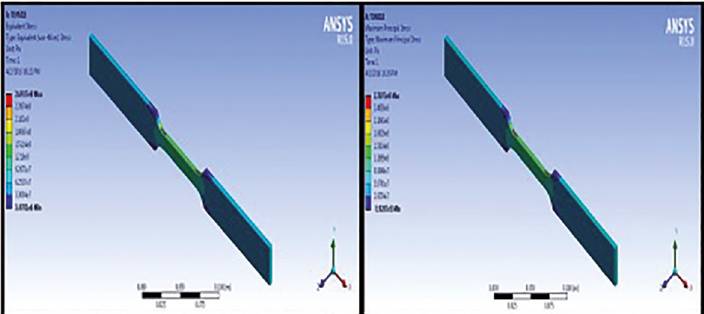
Figure 13: Typical stress distribution due to tensile loading